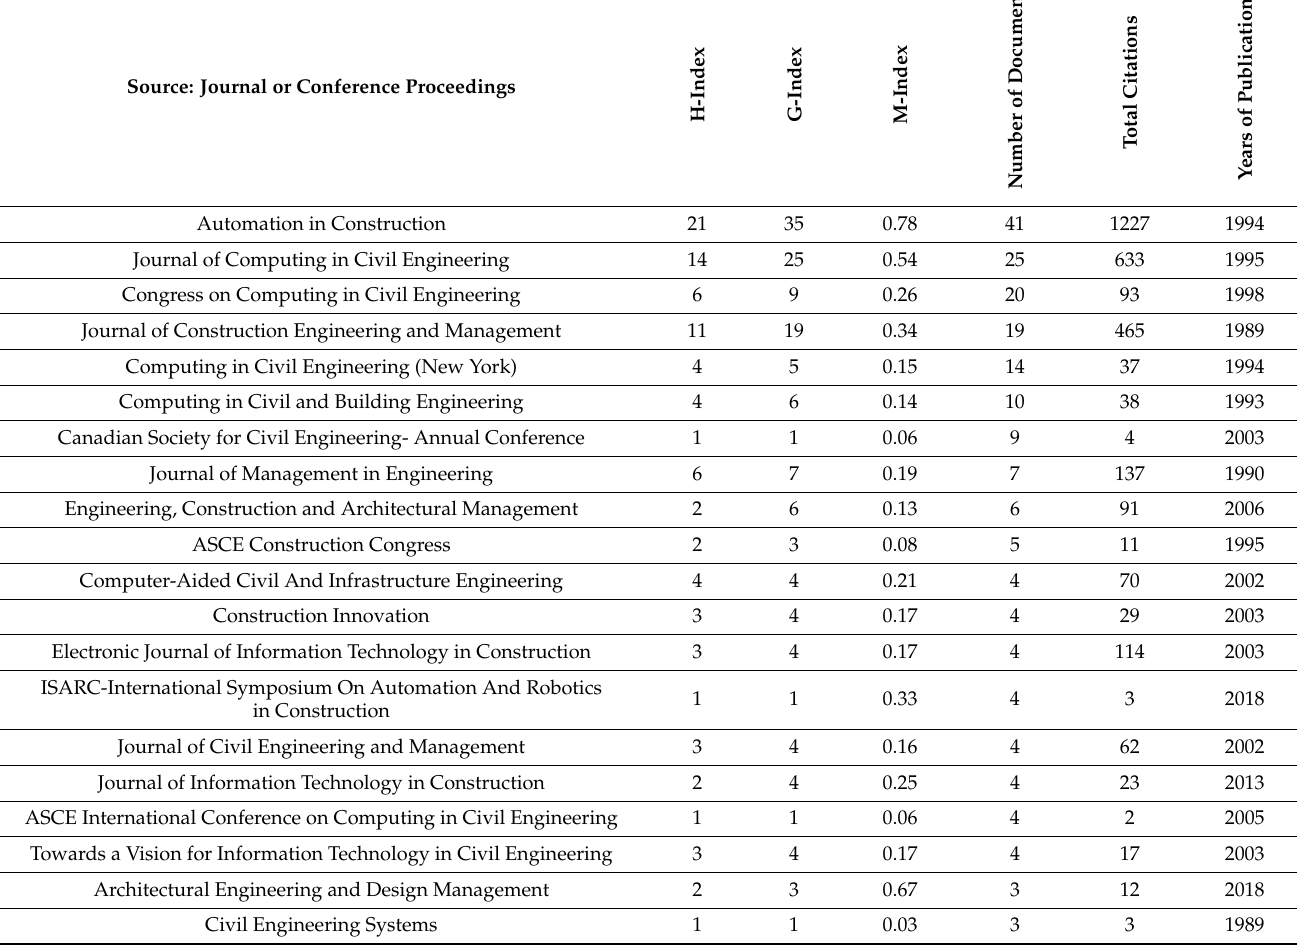
Table 8. H, G, and M-index sources